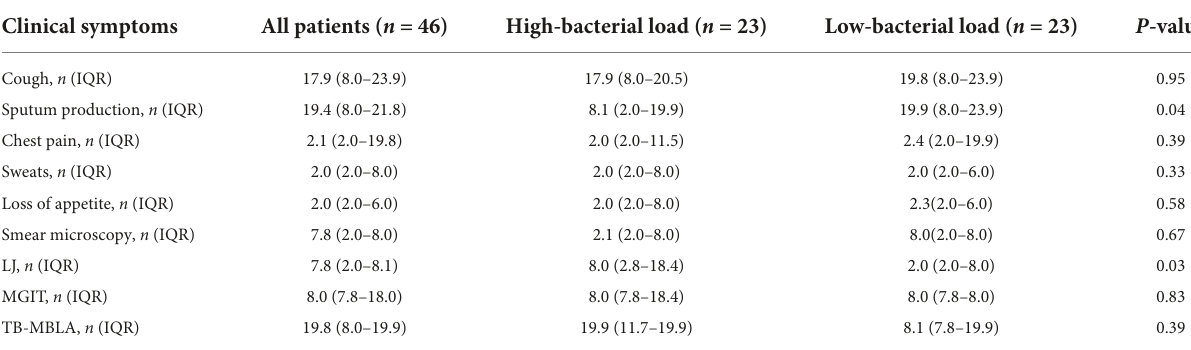
TABLE 3 Time to the resolution of clinical and bacteriological measures stratified by bacterial